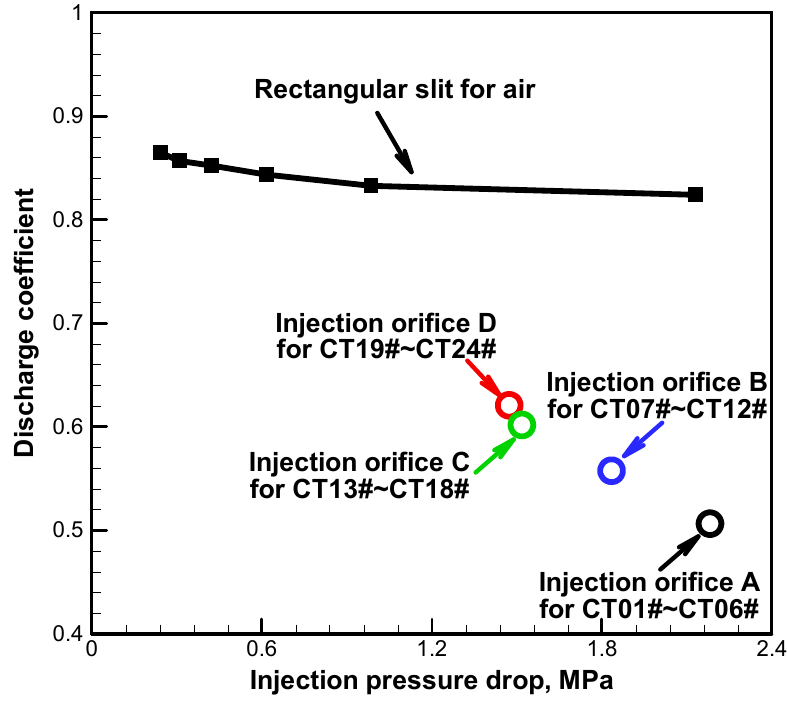
Figure 3. Variances in the discharge coefficients with the injection pressure drop.